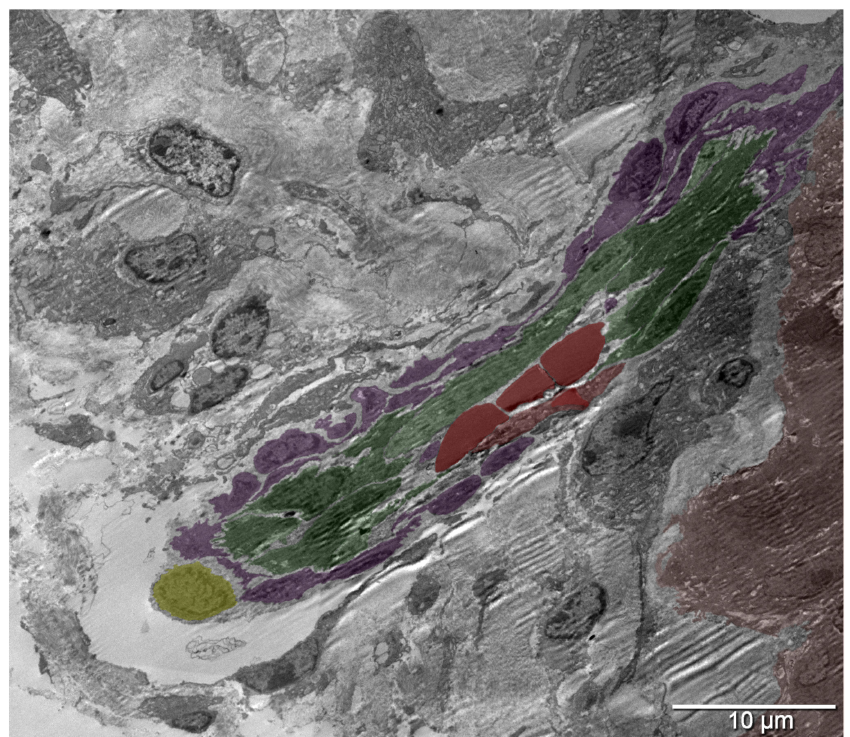
Figure S13. Morphogenesis of an artery (II). A second forming complex vessel had a corrugated basement membrane at both ends of the elongated structure suggesting that the one in Figure S8 might have been cut not exactly parallel to its long axis. A round cell (bright yellow) surrounded by a collagen-free region at the lower end suggested growth in that direction which happened to be pointing towards the first artery Figure S8 [C].